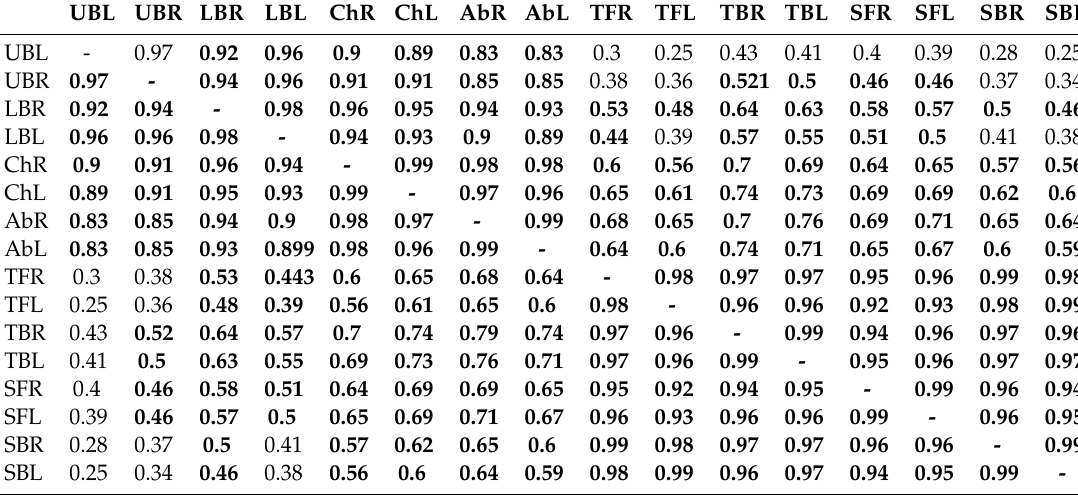
Table 4. Values of the correlation coe ffi cient between the mean values of the temperatures of selected body areas in healthy